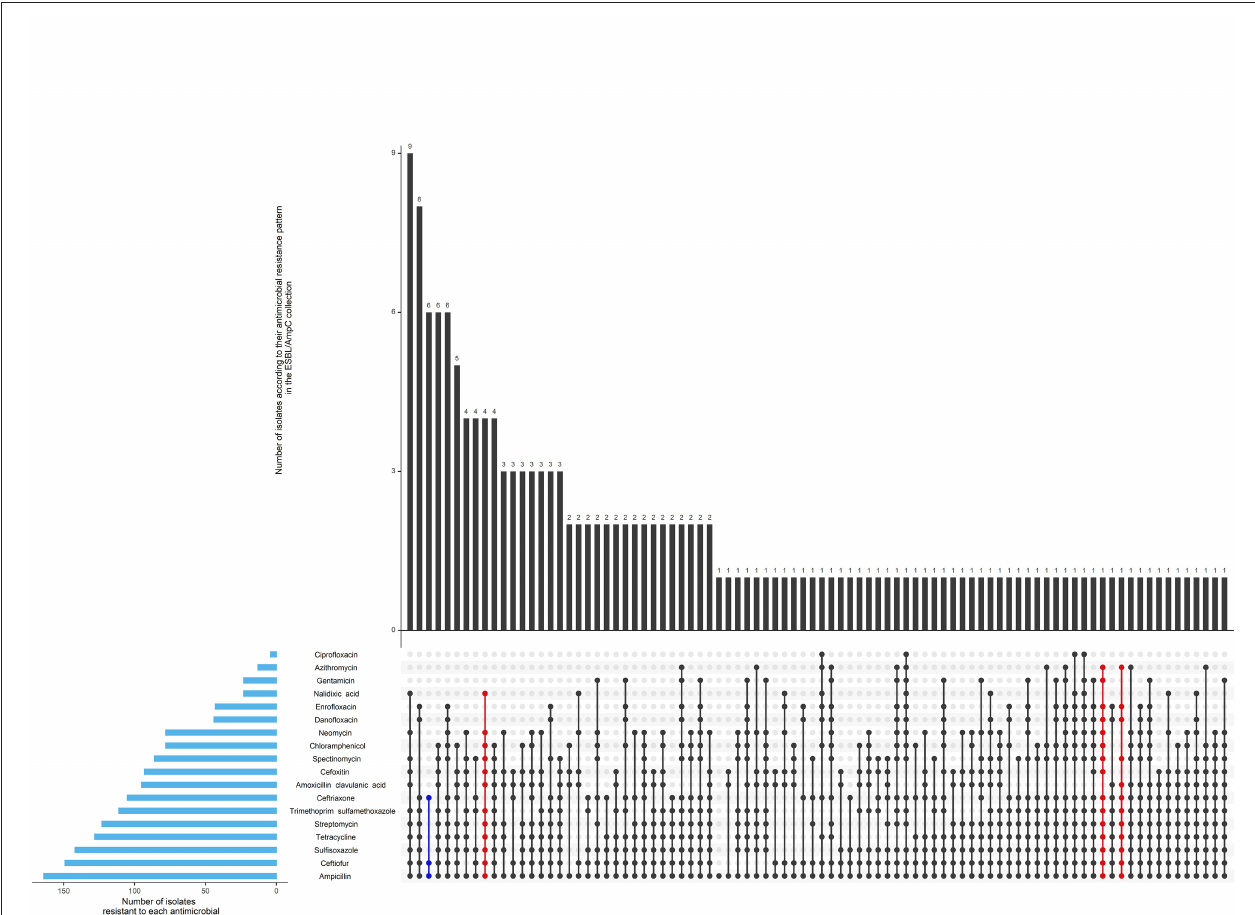
FIGURE 6 | Antimicrobial resistance pattern of 162 isolates of the ESBL/AmpC collection from calf, cow feces or manure pit of 87 dairy farms in Québec, Canada in 2020–2021. The horizontal blue bars represent the frequency of isolates resistant to each antimicrobial. An antimicrobial pattern is represented by the linked dots. Black dots represent the MDR patterns, and red dots represent the XDR patterns. The vertical bars represent the frequency of isolates for each antimicrobial pattern.